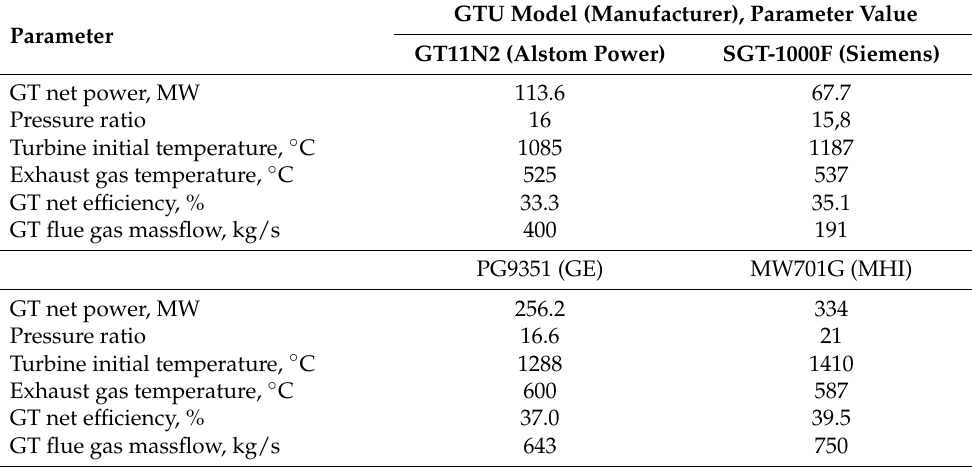
Table 3. Nominal characteristics of the gas turbines.